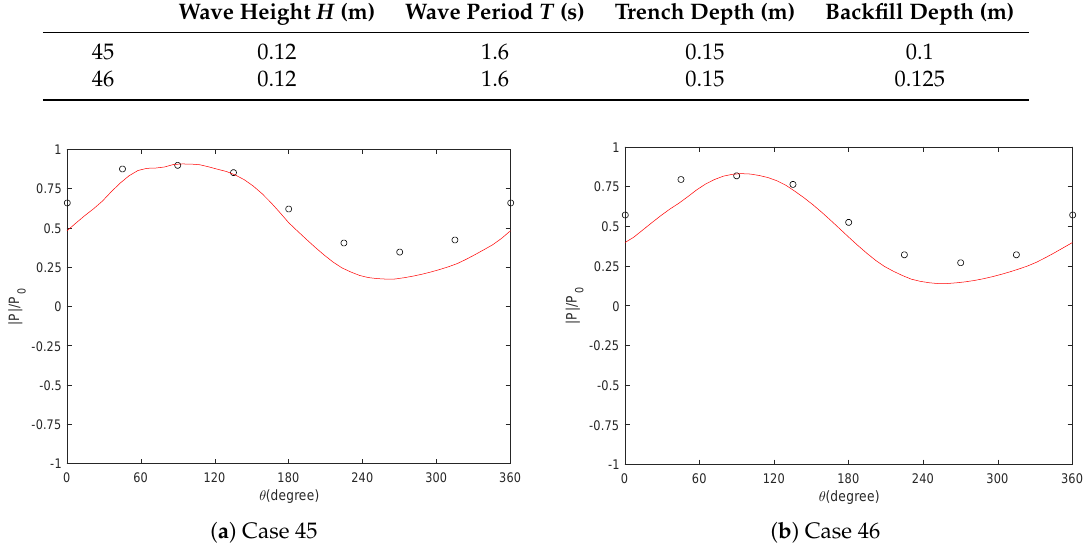
Table 3. Wave and seabed conditions for the comparison with experimental data [40]. Case No.